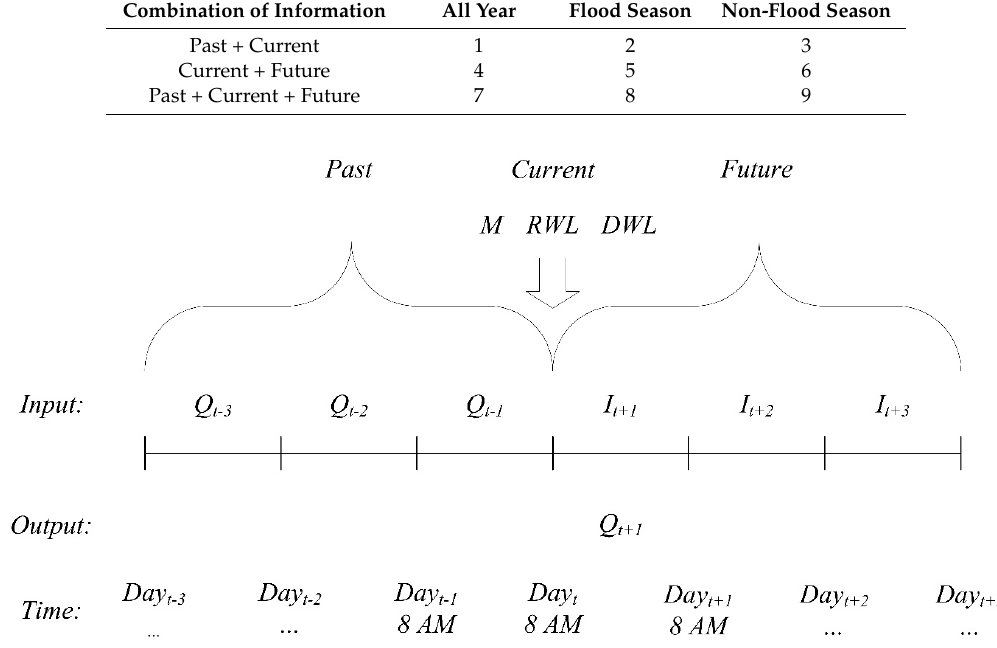
Figure 1. Schematic map illustrating the past, current and future hydrologic information.